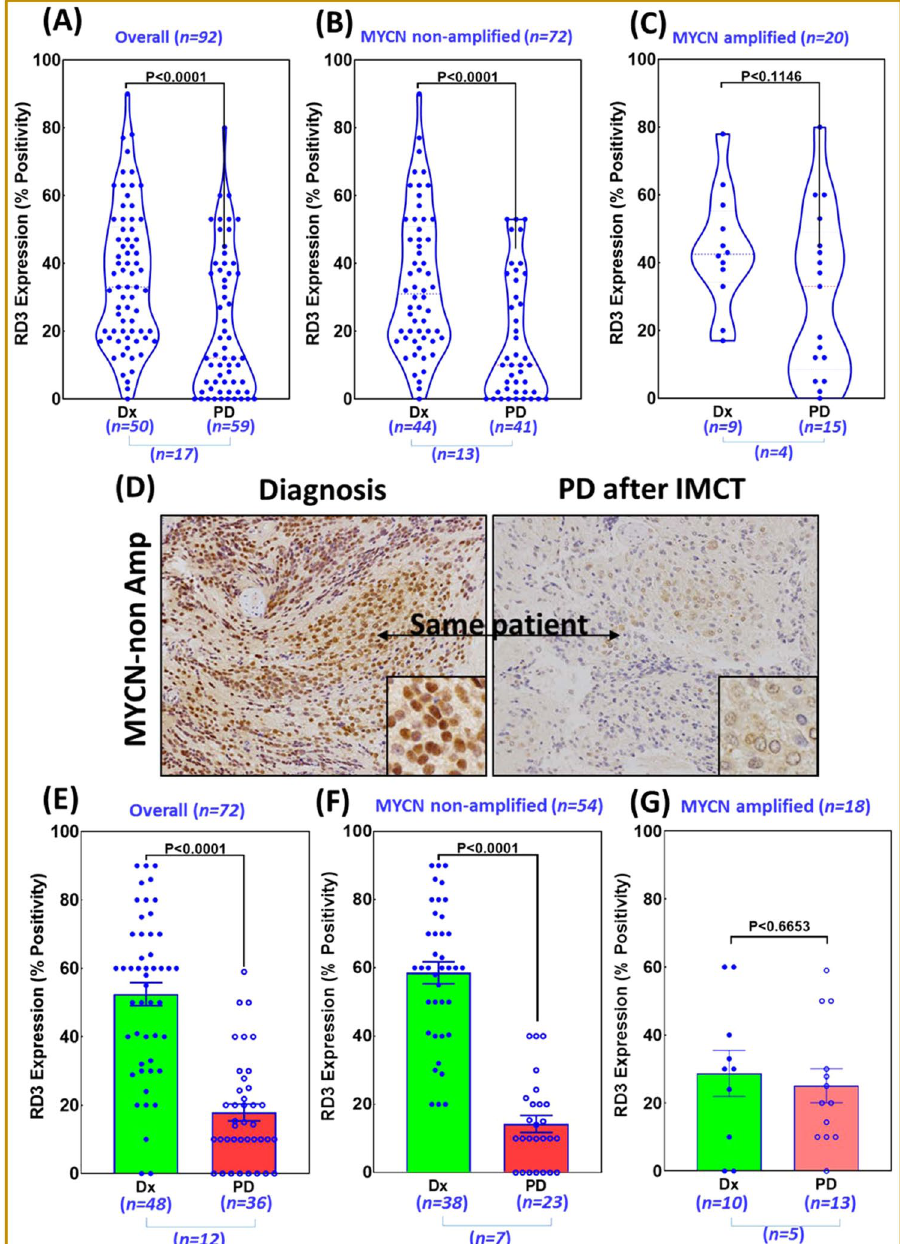
Figure 3. Acquisition of RD3 loss in progressive disease after clinical therapy: ( A – C ) RD3 RNAscope analysis showing levels of RD3 mRNA in NB specimens procured during diagnosis (Dx) or at progressive disease after IMCT (PD). Violin plots constructed for ( A ) overall NB patient cohort, ( B ) MYCN-na NB subset and ( C ) MYCN-a NB subset showing fluctuation in RD3 transcription between DX and PD. ( D ) Representative photomicrographs of RD3 immunohistochemistry showing levels of RD3 (20 × , insert 60 × ) in matched (same patient) disease at Dx and PD after IMCT (ii). ( E – G ) RD3-IHC analysis showing RD3 protein levels in NB specimens procured during Dx or at PD after IMCT. Histograms of RD3-IHC quantification showing fluctuations of RD3 expression in PD after IMCT ( vs . disease at Dx) in ( E ) overall NB patient cohort, ( F ) MYCN-na subset and ( G ) MYCN-a subset. ‘ n’ indicates number of cases per group, ‘ ˽ ’ indicates n number of patients with both Dx and PD specimens. Group-wise comparisons ( t- test) were made using GraphPad PRISM